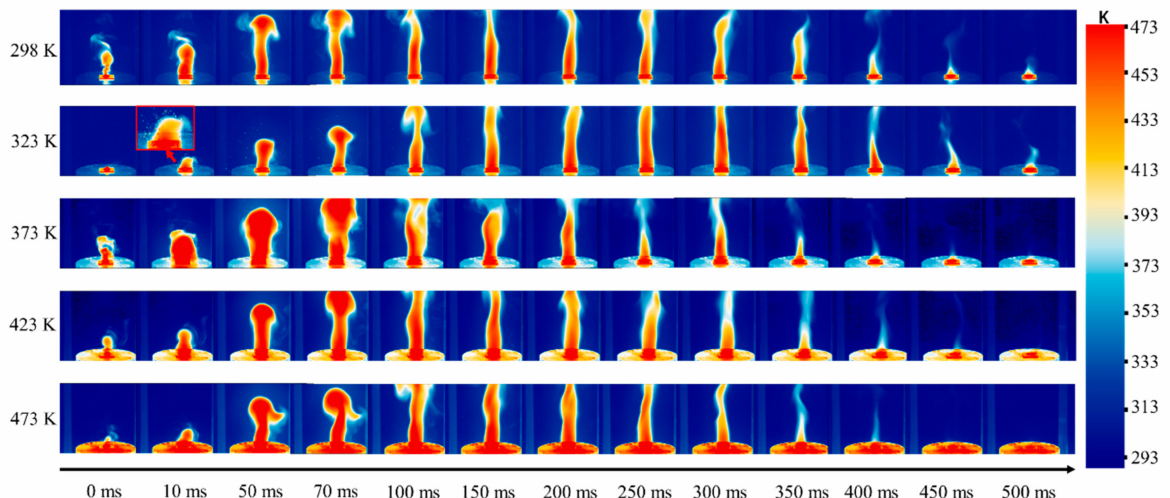
Figure 8. Flame thermal radiation at different initial temperatures (although the temperature is not the flame temperature, the change in color bar can represent the flame thermal radiation